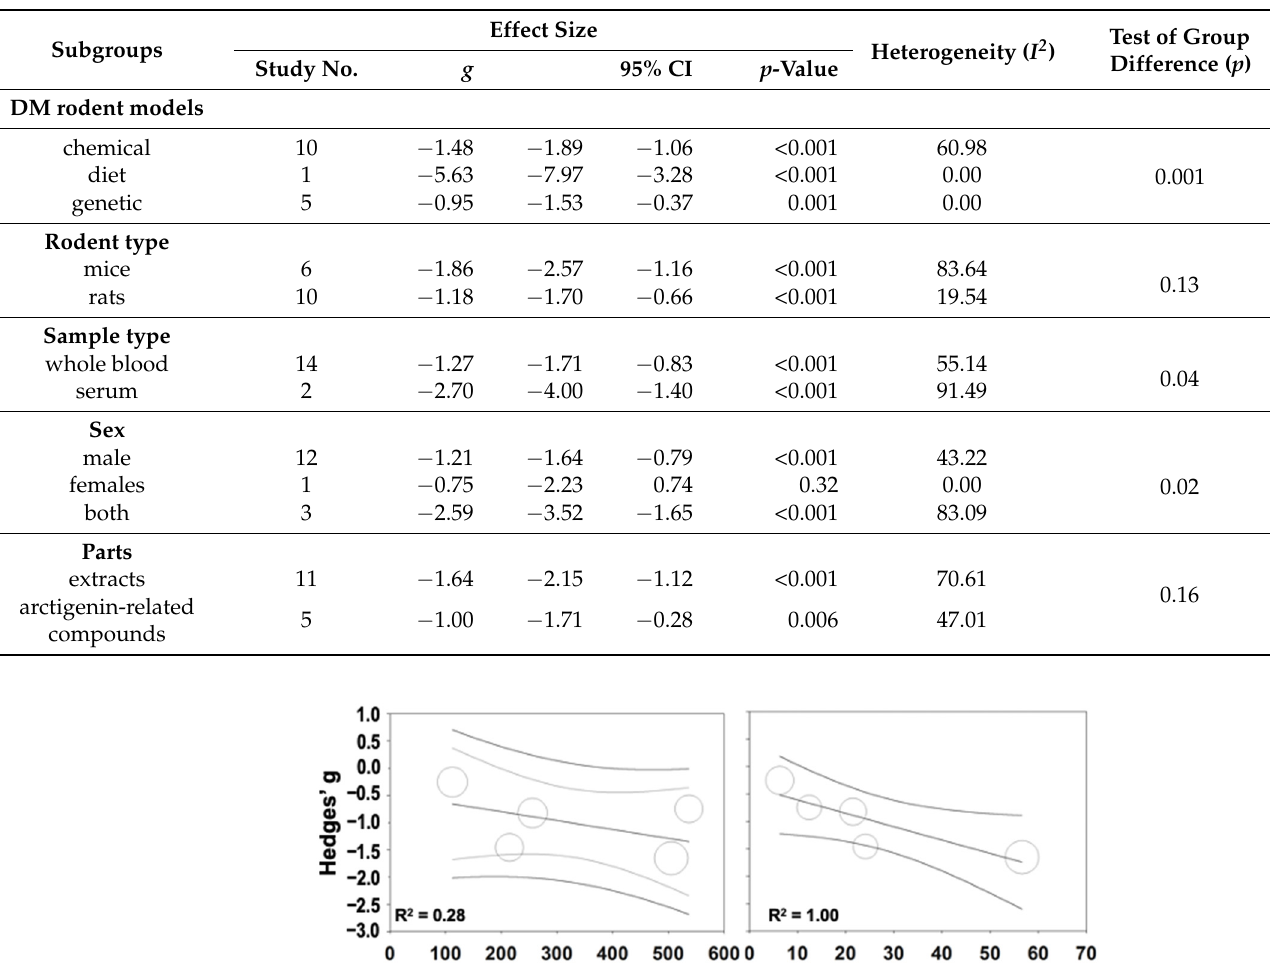
Table 2. Subgroup analyses of BG levels in DM animals.